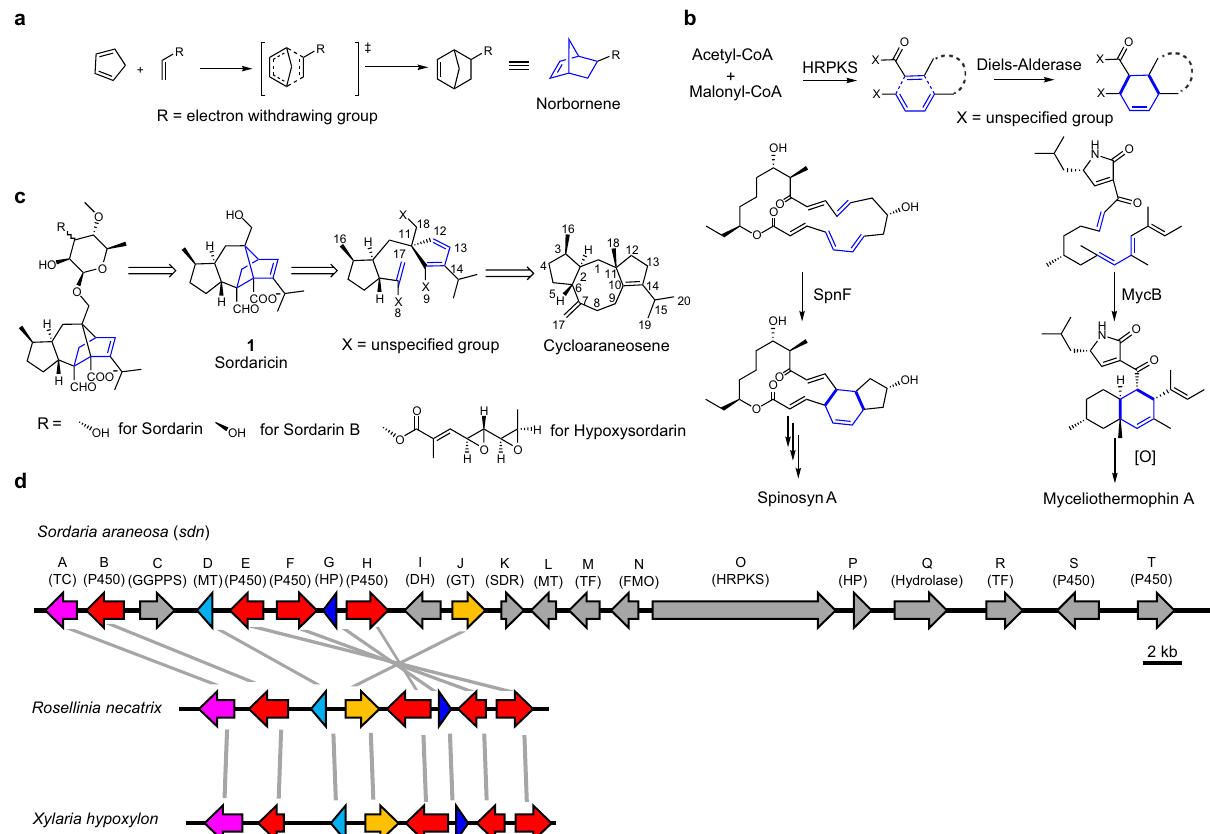
Fig. 1 Biosynthesis of sordaricin is an example of the classical norbornene forming Diels-Alder reaction in Nature. a DA reaction between a cyclopentadiene and a substituted ole fi nic dienophile yielding norbornene. b Well characterized IMDA reactions in biosynthesis of polyketides and polyketide-nonribosomal peptide hybrid natural products. HRPKS, highly reducing polyketide synthase. c Retro-biosynthetic scheme of sordarins. The numbering of cycloaraneosene follows Kudo, et al 27 . d BGCs for hypoxysordarin ( sdn ) and sordarin B (putative). Genes in sdn but absent from the sordarin B cluster are colored gray. TC, terpene cyclase; GGPPS, geranylgeranyl pyrophosphate synthase; MT, methyl transferase; HP, hypothetical protein; DH, dehydratase; GT, glycosyl transferase; SDR, short chain reductase; TF, transcription factor; FMO, fl avin-dependent monooxygenase. NATURE COMMUNICATIONS| (2022) 13:2568